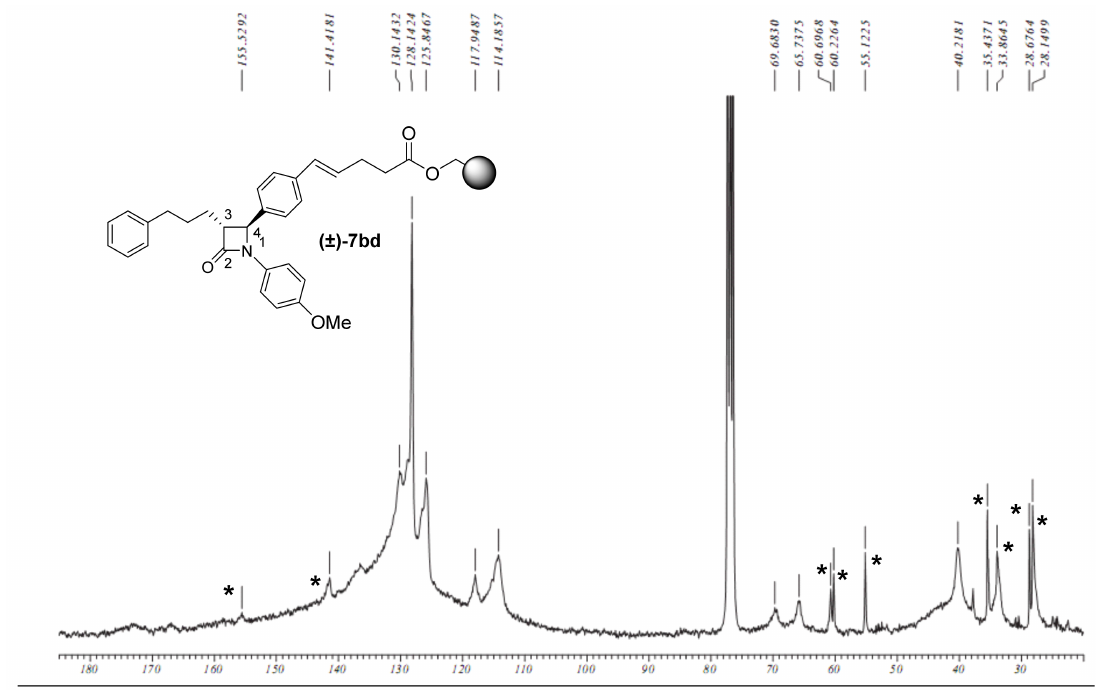
Figure 4. 13 C gel-phase NMR of immobilized β -lactam 7bd